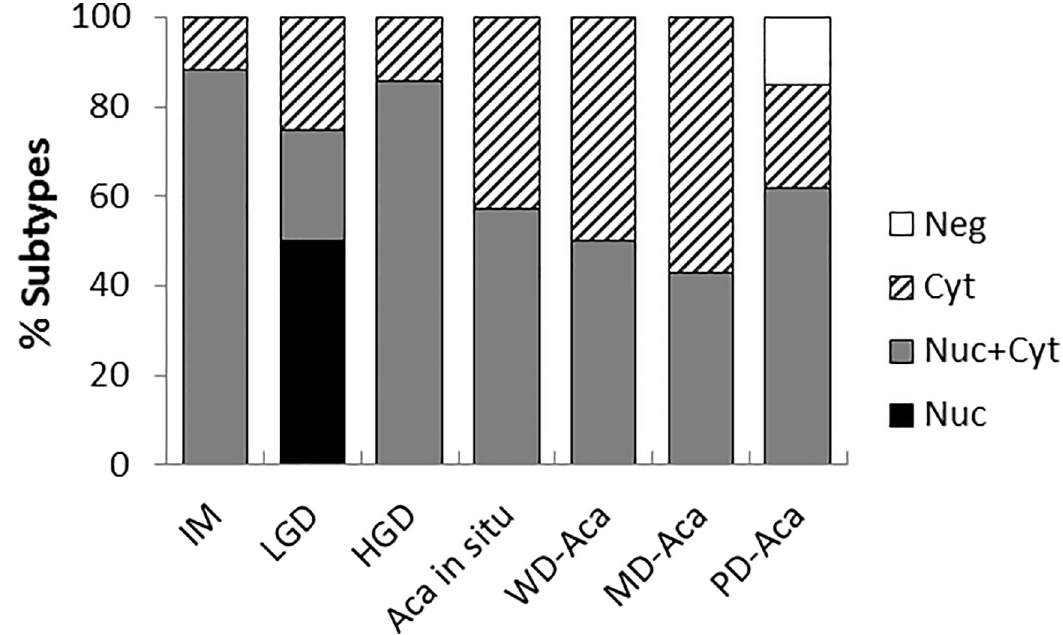
Fig 3. Profiles of maspin expression subtype in different ECA/GEJ pathological diagnosis. The contribution of each subtype is presented as a percentage of the total number of cases of each pathological grade. Nuc: nuclear only; Nuc+Cyt: combined nuclear and cytoplasmic; Cyt: cytosolic only; and Neg: no maspin detection.